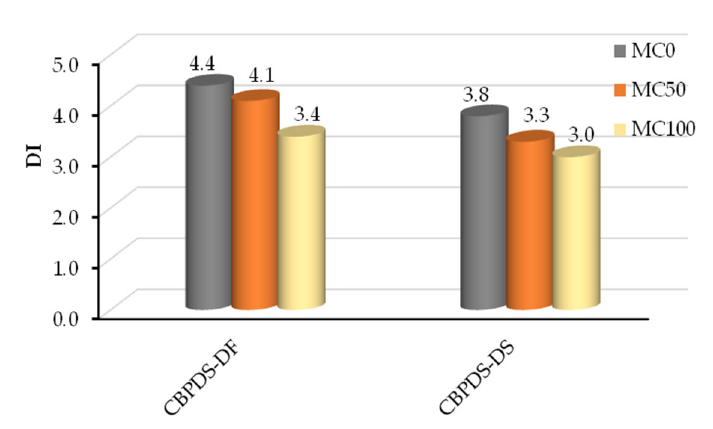
Figure 16. Ductility index (DI) of tested